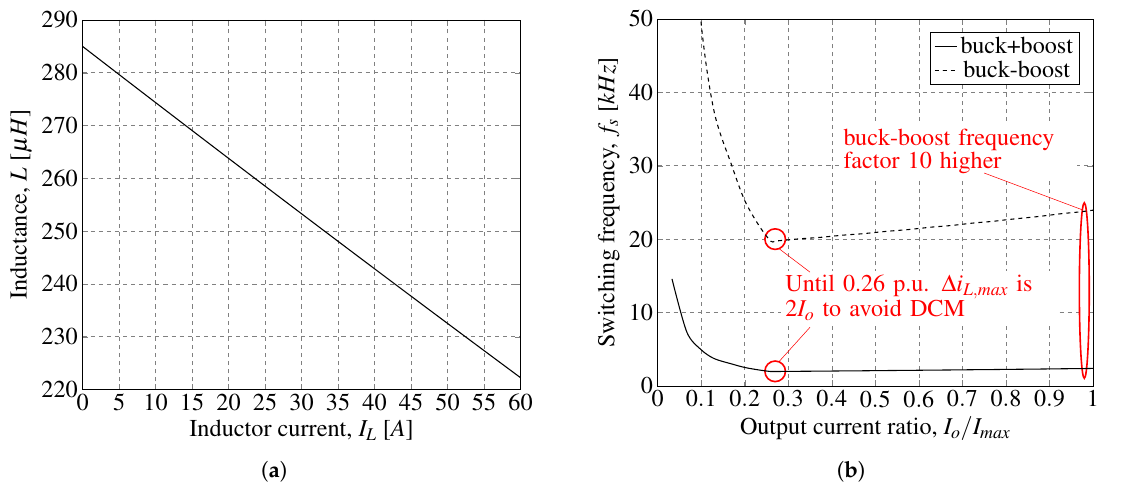
Figure 12. Inductance–current relationship of the powder cores and corresponding switching fre- quency for buck + boost mode and buck–boost mode: ( a ) inductance versus inductor current; ( b ) switching frequency for buck–boost and buck + boost mode for overlapping input and output voltages of 330